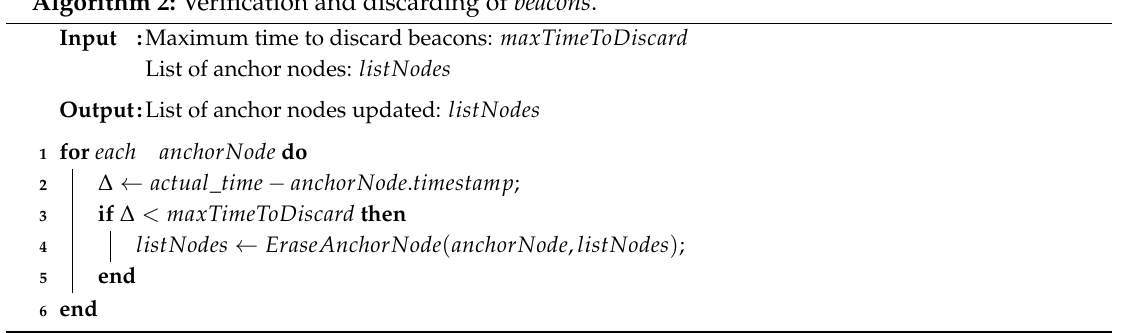
Algorithm 2: Verification and discarding of beacons